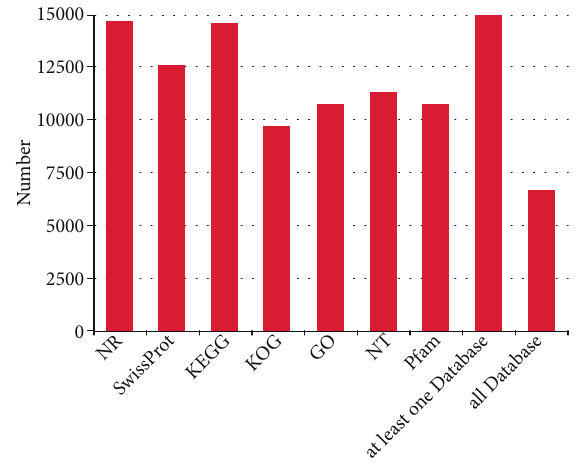
Figure 4: Frequency and distribution of SSRs on the basis of the